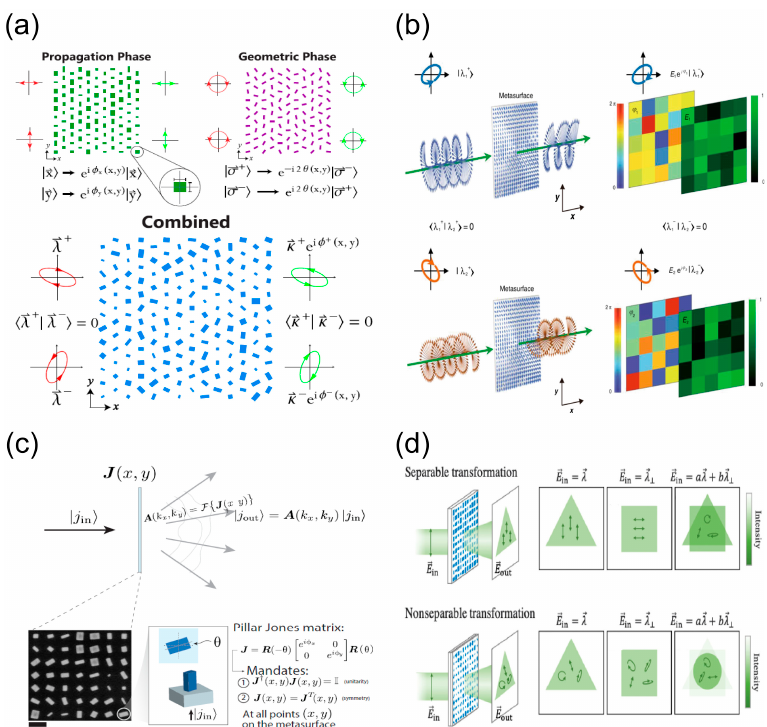
Figure 4. Polarization control using form-birefringent metasurfaces. ( a ) Control of orthogonal polarizations by combining the propagation and geometric phases [167]. ( b ) Complete and independent control of the complex amplitude for orthogonal polarization states [168]. ( c ) Jones matrix holography using birefringent metasurfaces [169]. ( d ) Principles of non-separable and separable polarization wavefront transformations [170].